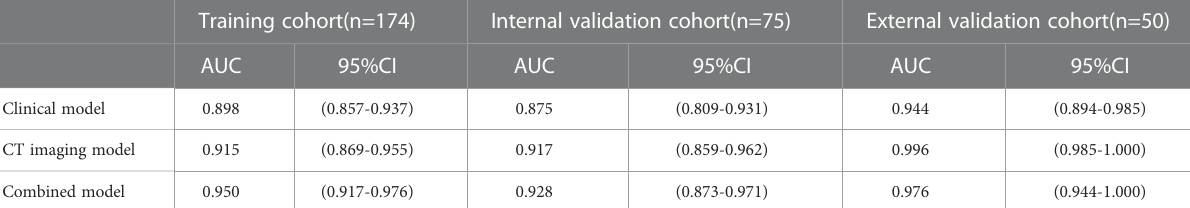
TABLE 7 ROC values of three models for PM-SCLC.